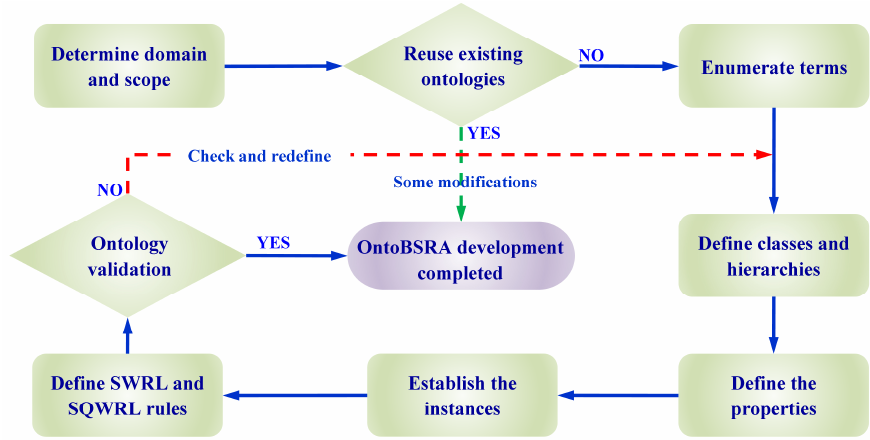
Figure 3. Procedure of the OntoBSRA